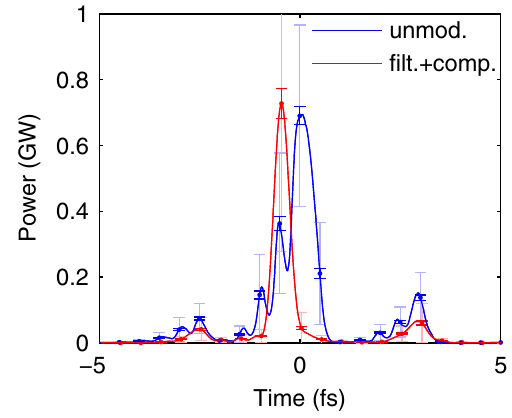
FIG. 9. Comparison of unmodified to filtered and compressed radiation pulses at 37.7 m averaged over 100 shot-noise seeds.